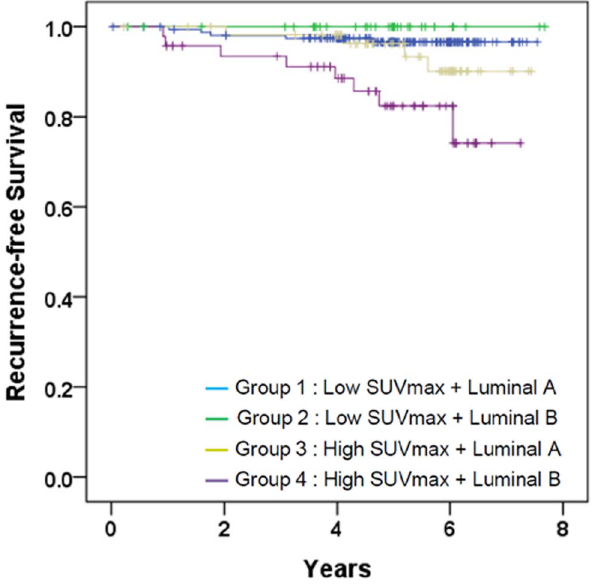
Figure 3. Kaplan-Meier plots stratified by combined factors with SUV max and the intrinsic subtype: Group 1, low SUV max and luminal A (n=163); Group 2, low SUV max and luminal B (n=35); Group 3, high SUV max and luminal A (n=60); Group 4, high SUV max and luminal B (n=47). P -value calculated by the log- rank test was